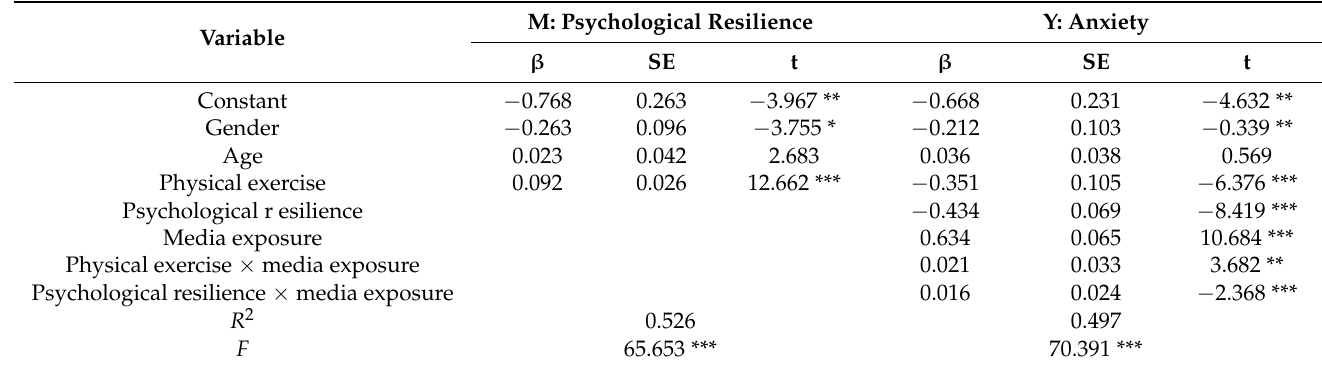
Table 7. Regression analysis of the moderating model.